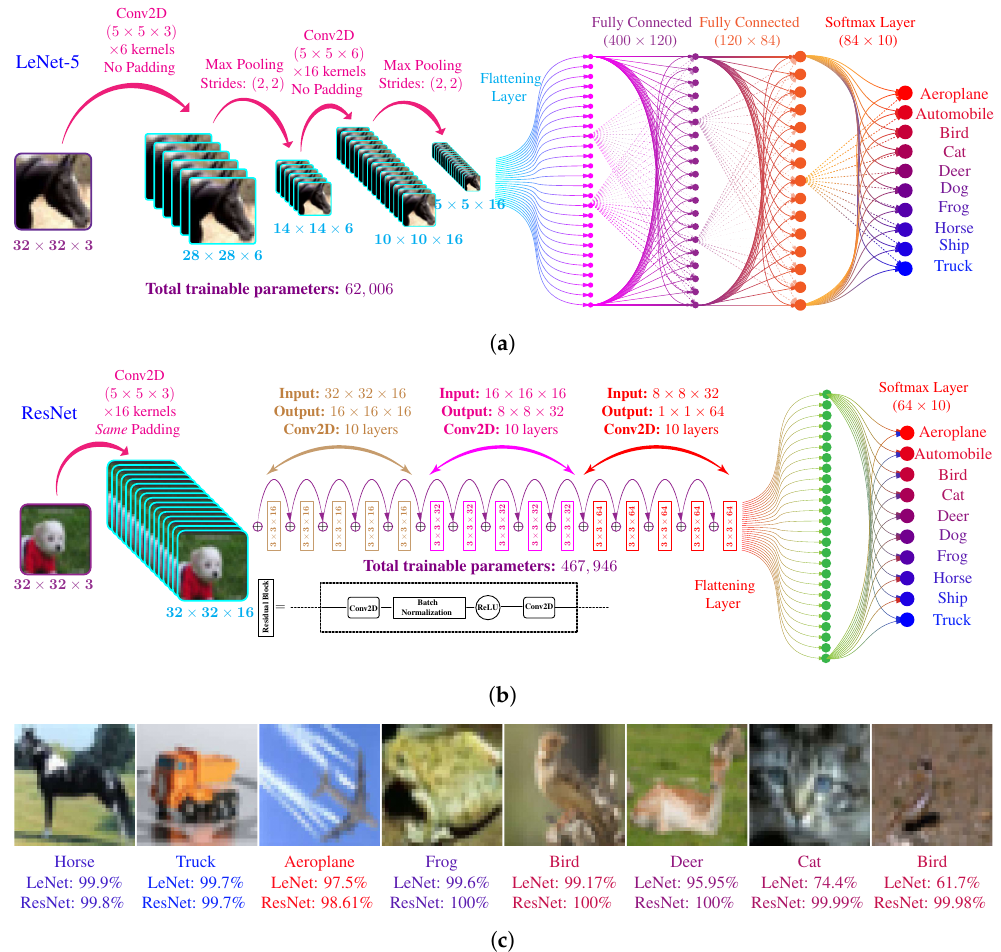
Figure 8. CNN architecture used for experiments in this paper. ( a ) Topology of LeNet-5, it contains a total of 5 trainable layers. ( b ) Topology of ResNet, it contains a total of 32 trainable layers. ( c ) Predic- tion of trained LeNet-5 and ResNet models for sample images of CIFAR-10 dataset. ResNet usually show high confidence as compared to LeNet-5 because of higher number of